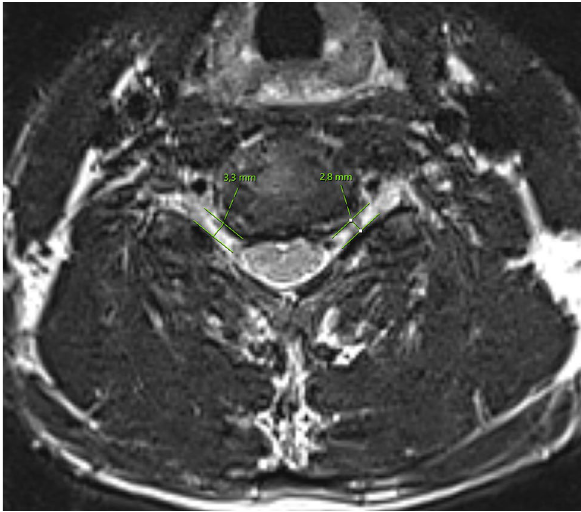
Figure 2. SDI measurement. Bilateral foraminal stenosis (1